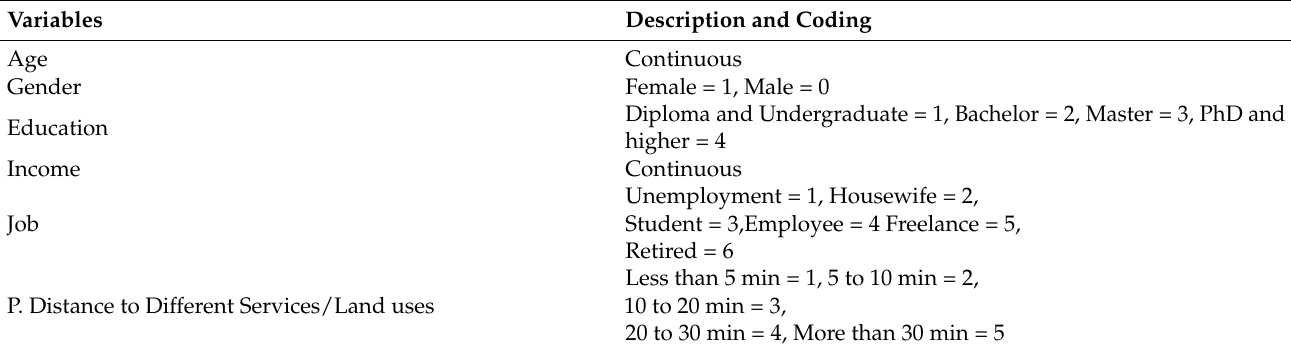
Table 1. Socio-economic, subjective, and objective